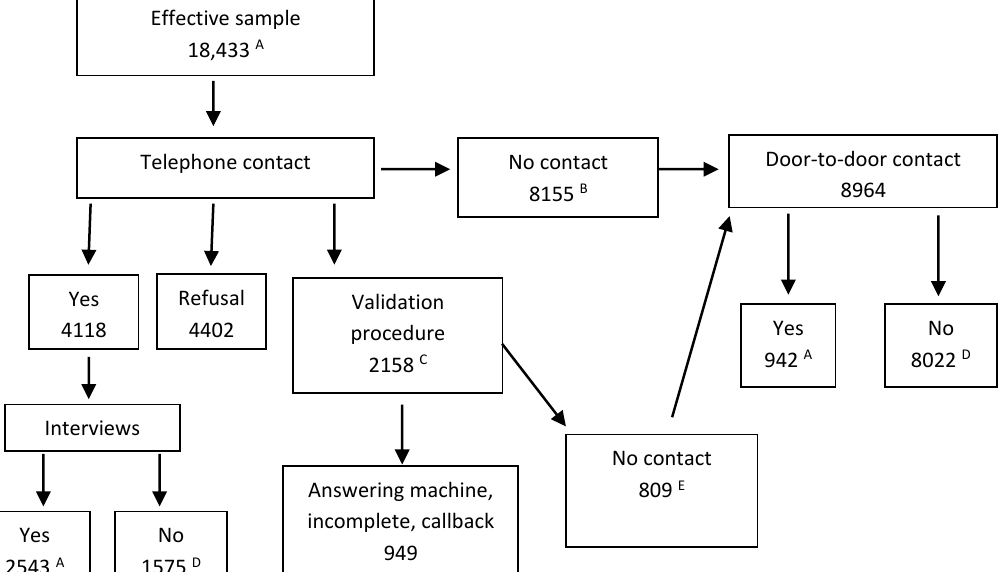
Figure 1. Distribution of the sample of